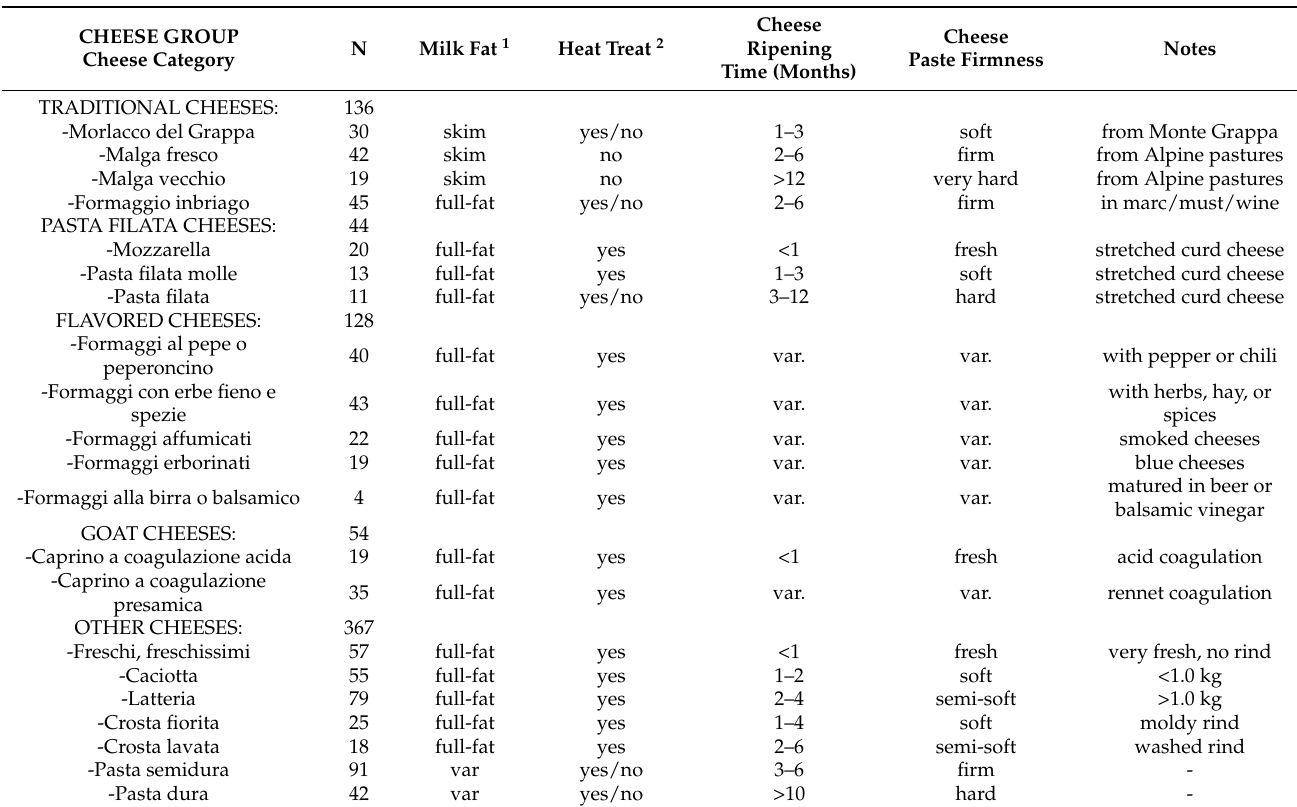
Table 2. Main characteristics and cheese-making techniques of the 4 traditional, 3 pasta filata, 5 flavored, 2 goat, and 7 other cheese categories without PDO status ( n = 729